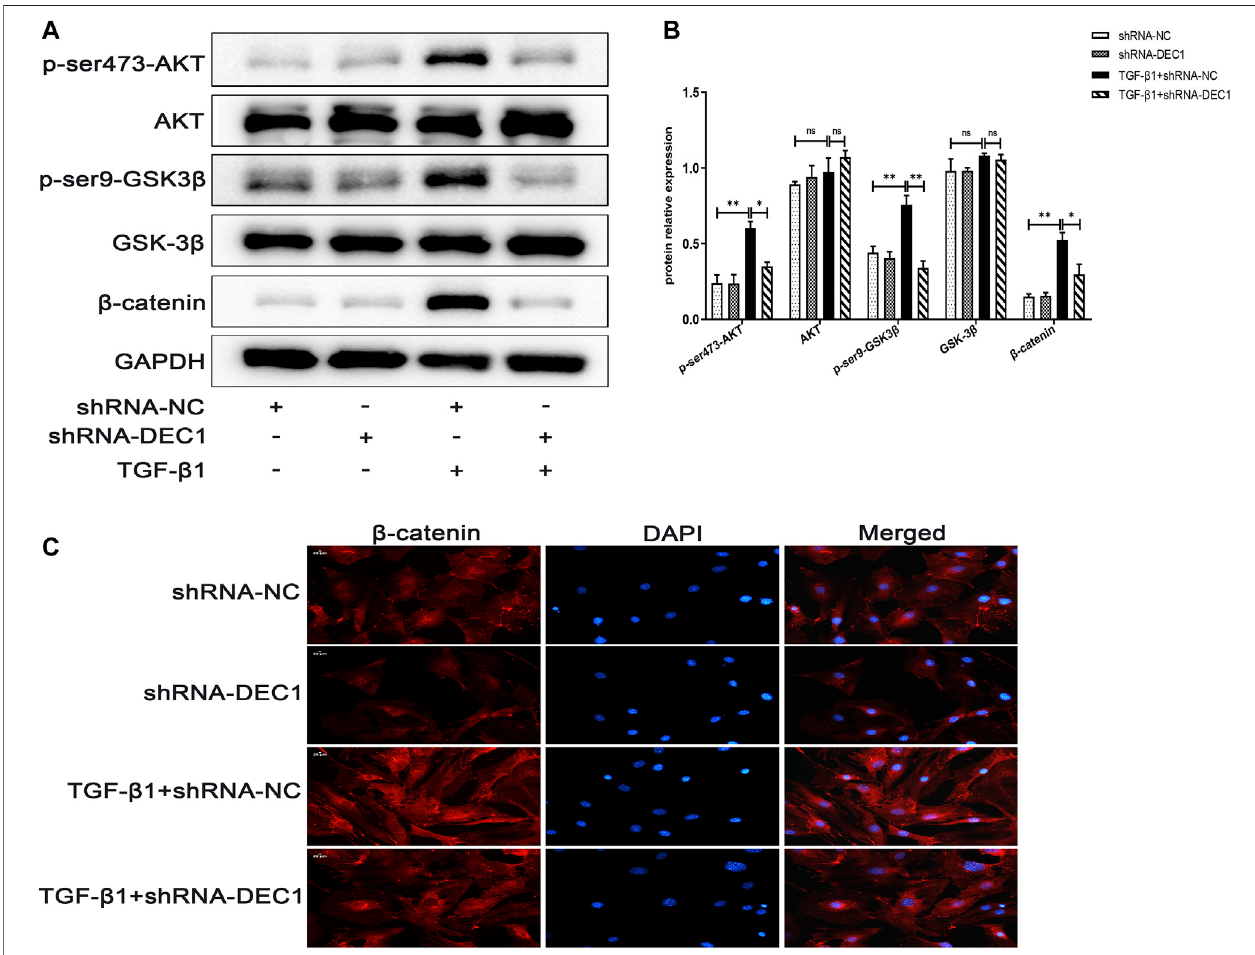
FIGURE 9 | DEC1 KD reduces the activation of the PI3K/AKT/GSK-3 β / β -catenin signaling pathway in A549 cells . shRNA-NC and shRNA-DEC1 A549 cells were treated with or without TGF- β 1 for 48 h. (A) The protein expression of p-ser473-AKT, AKT, p-ser9- GSK3 β , GSK-3 β , and β -catenin in A549 cells were measured by western blotting. (B) Statistical analysis of relative expression levels of proteins in A. (C) Immuno- fl uorescent analysis for β -catenin expression in A549 cells. Scale bar = 20 μ m n = 3. Data are shown as the mean ± SEM. Statistical analysis was performed by one-way ANOVA. * p < 0.05, ** p < 0.01, *** p < 0.001, ns p > 0.05.